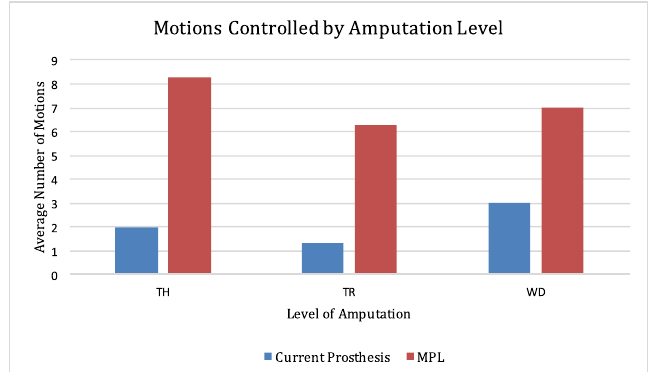
Figure 1. Average number of motions controlled by amputation level, defined as transhumeral, transradial and wrist disarticulation, with participants’ conventional prosthesis (current) compared to the